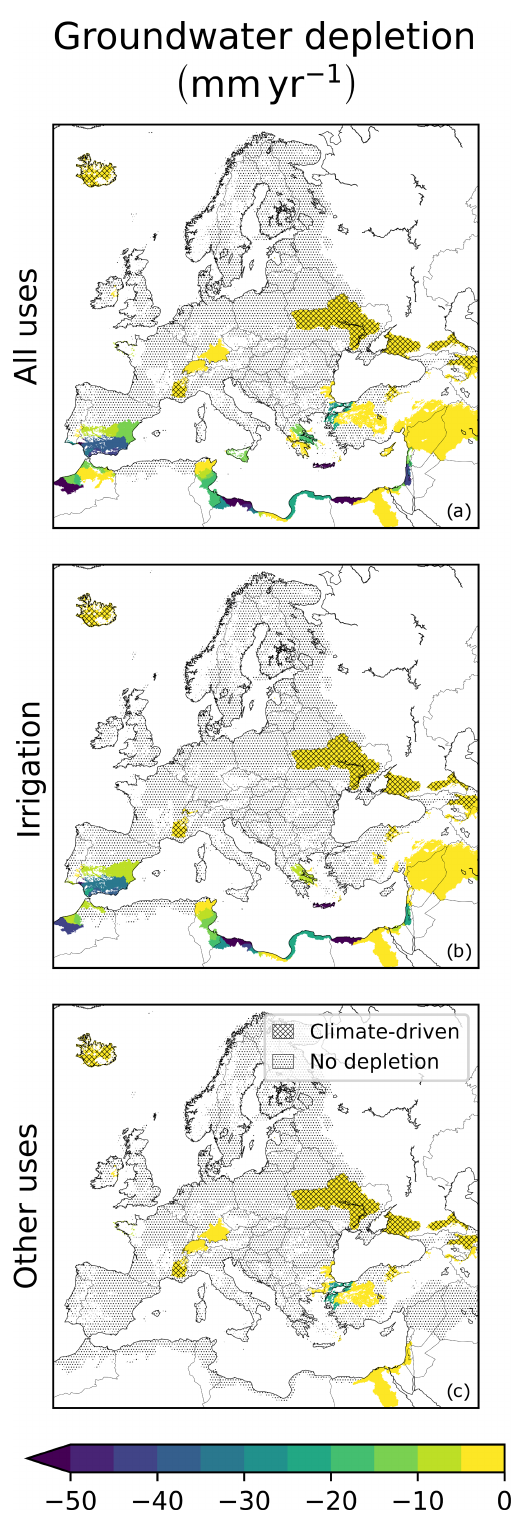
Figure 4. Groundwater depletion rates simulated by the LISFLOOD-EPIC model for the 1990–2018 period, including (a) abstractions by all sectors; (b) abstractions by irrigation only; and (c) abstractions by all sectors except irrigation (household, industry, livestock and energy). Displayed rates are linear trend slopes computed over WURs and tested for statistical significance. Dotted are aquifer locations where no statistically significant depletion is found. Over barred areas, at least 90% of total depletion rates are also simulated without water abstractions and thus are mostly driven by climate (Fig. S1 in the Supplement). White land areas within the Euro-Mediterranean model domain have no exploitable aquifers (Fig.